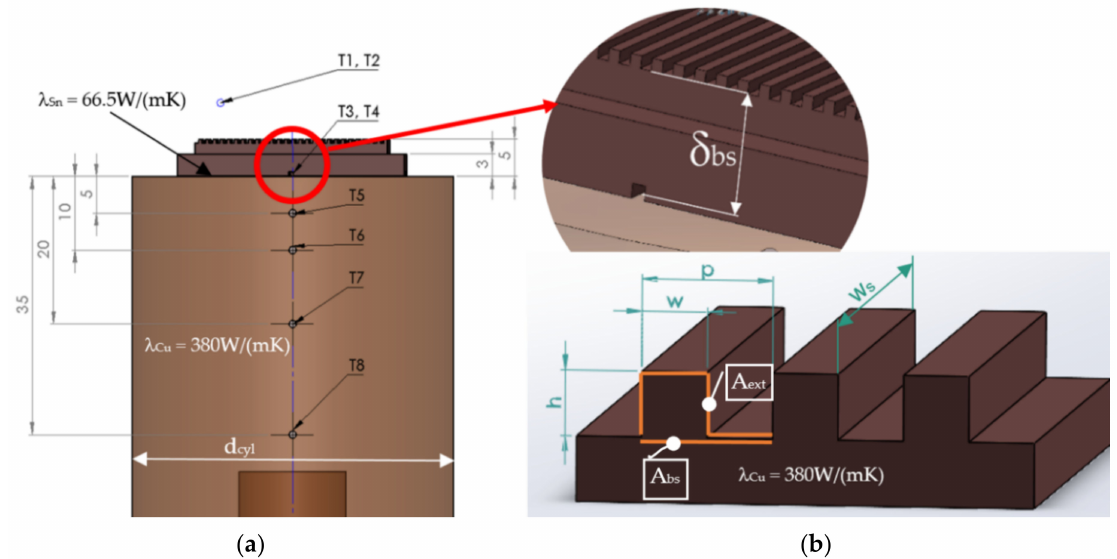
Figure 3. ( a ) Arrangement of thermocouples; ( b ) specimen with microchannel dimension. A PHOT MV-D1024-160-CL (Photonfocus) digital monochromatic camera with